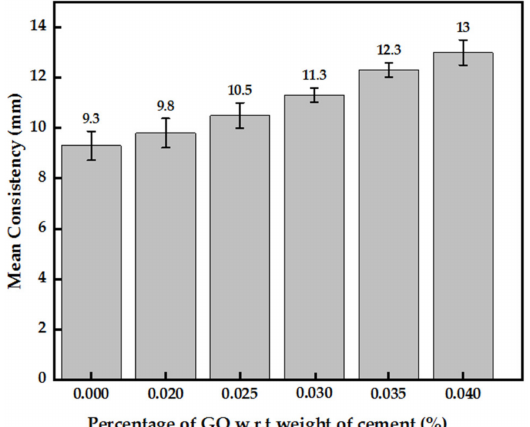
Figure 4. Consistency of cement paste-incorporated with GO paste.